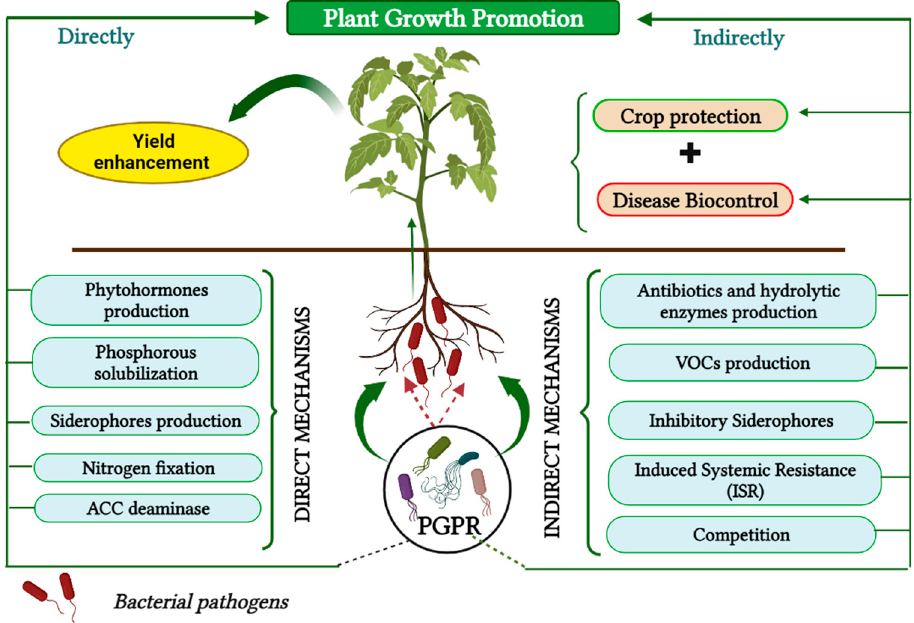
Figure 4. Schematic illustration of direct/indirect mechanisms of PGPRs to promote plant growth, maintain crop protection from pathogens, and improve yield.